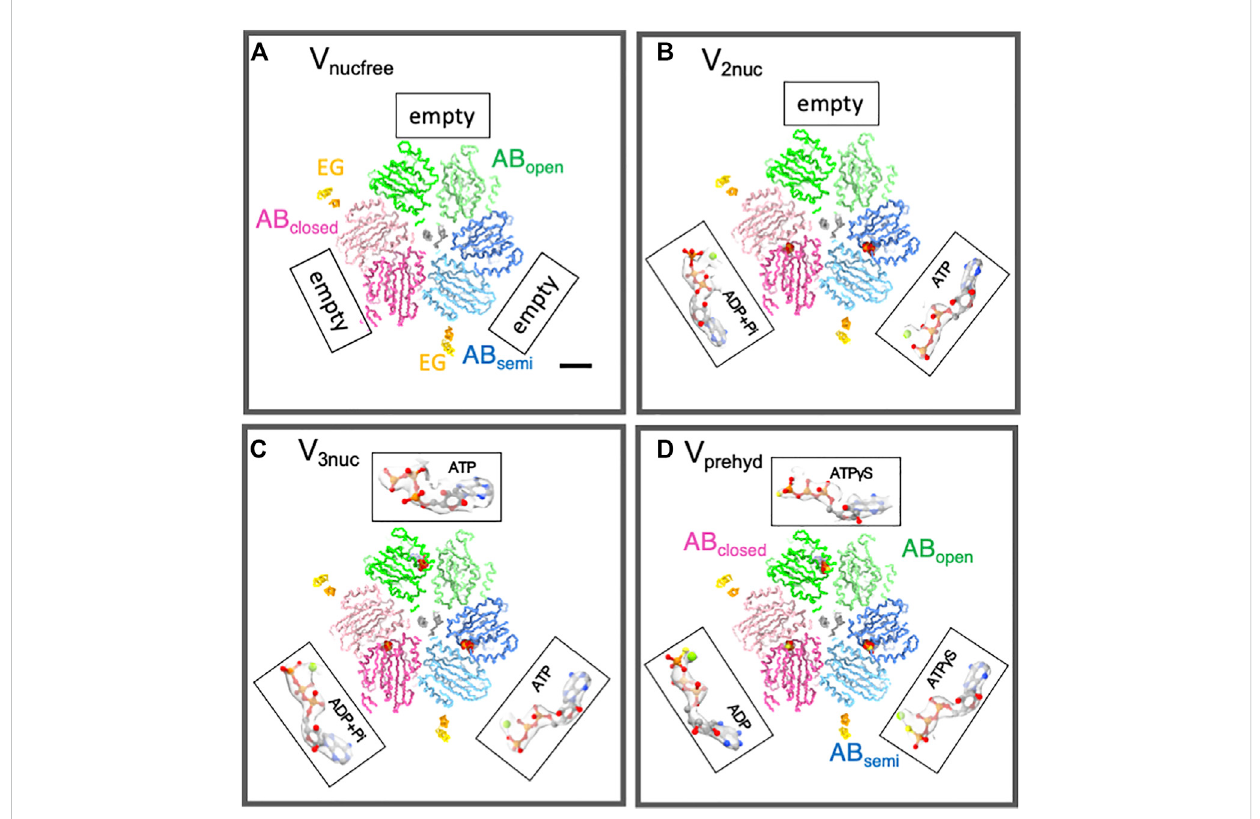
FIGURE 3 Structuresofnucleotidebindingsitesineachcondition.ThesliceofV nucfree (A) ,V prehyd (B) ,V 3nuc (C) ,andV 2nuc (D) viewedfromtheV 1 (cytosolic)side wereshownwithboundnucleotides.Thescalebaris20 Å.Threecatalyticdimers(AB open ,AB semi ,andAB closed )ineachstructureareshowningreen,blue, and pink, respectively. Two, EG peripheral stalks were shown in yellow. CryoEM maps were represented as semi-translucent. The magni fi ed view of bound nucleotides and Mg ions was highlighted as a ball-and-stick and sphere